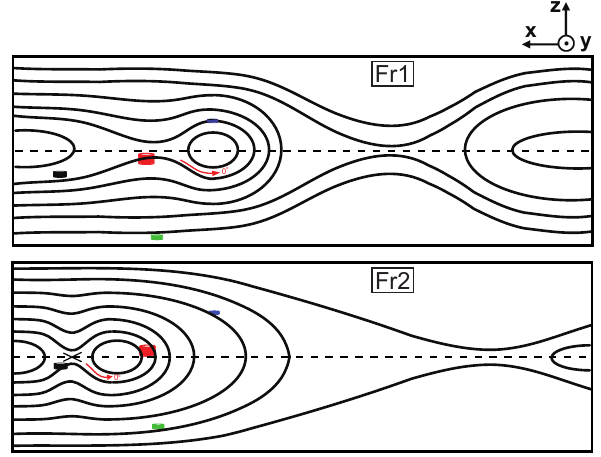
Fig. 4. Schematic illustrators for the two magnetic flux ropes Fr1 and Fr2 are presented. The four coloured columns correspond to the four satellites C1 (Black), C2 (Red), C3 (Green), and C4 (Blue). The different sizes of the spacecraft represent their displacements in y direction. The red lines with arrow denote the electron flow parallel to magnetic field